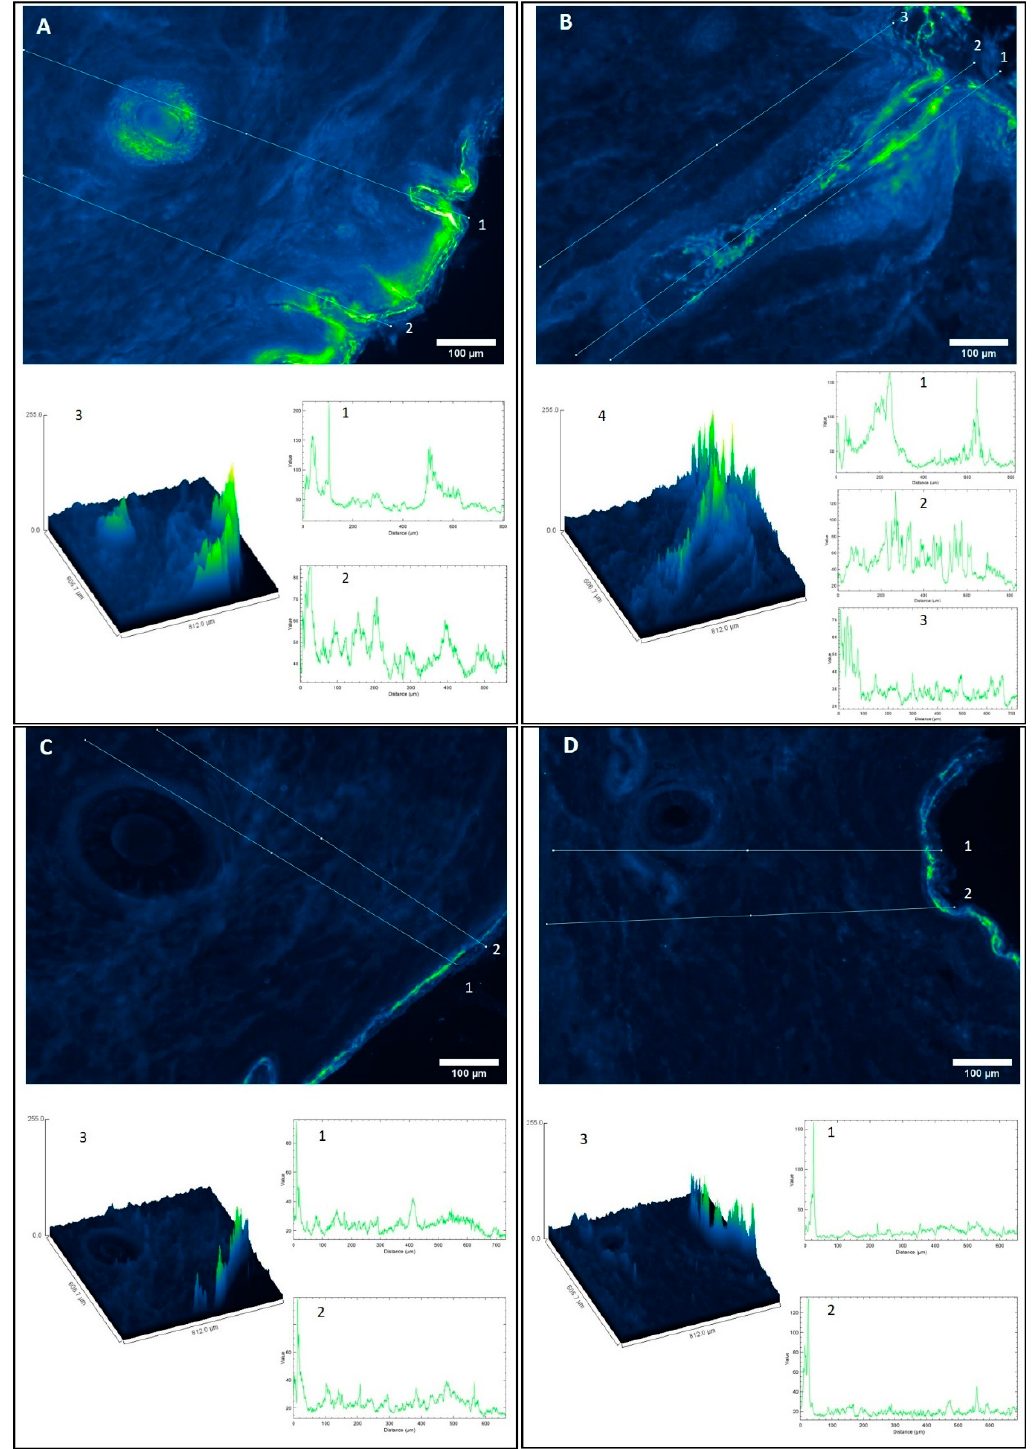
Figure 6. IHF images of a pig skin cross-section. Green color corresponds to high intensity and blue to lower intensity fluorescence of Alexa 488 secondary antibody (Ab)–Primary Ab–DEX complex: ( A , B ) DEX-loaded LPNCs; ( C , D ) hydroalcoholic DEX control solution. Figure 6A 1–2, Figure 6B 1–3, Figure 6C 1–2 and Figure 6D 1–2 correspond to green intensity plot profiles as function of the depth ( µ m). Figure 6A 3, Figure 6B 4, Figure 6C 3 and Figure 6D 3 correspond to surface plots. The images were captured using 10 × magnifications and the Lookup Table (LUT) used to show the pictures was Green Fire Blue.